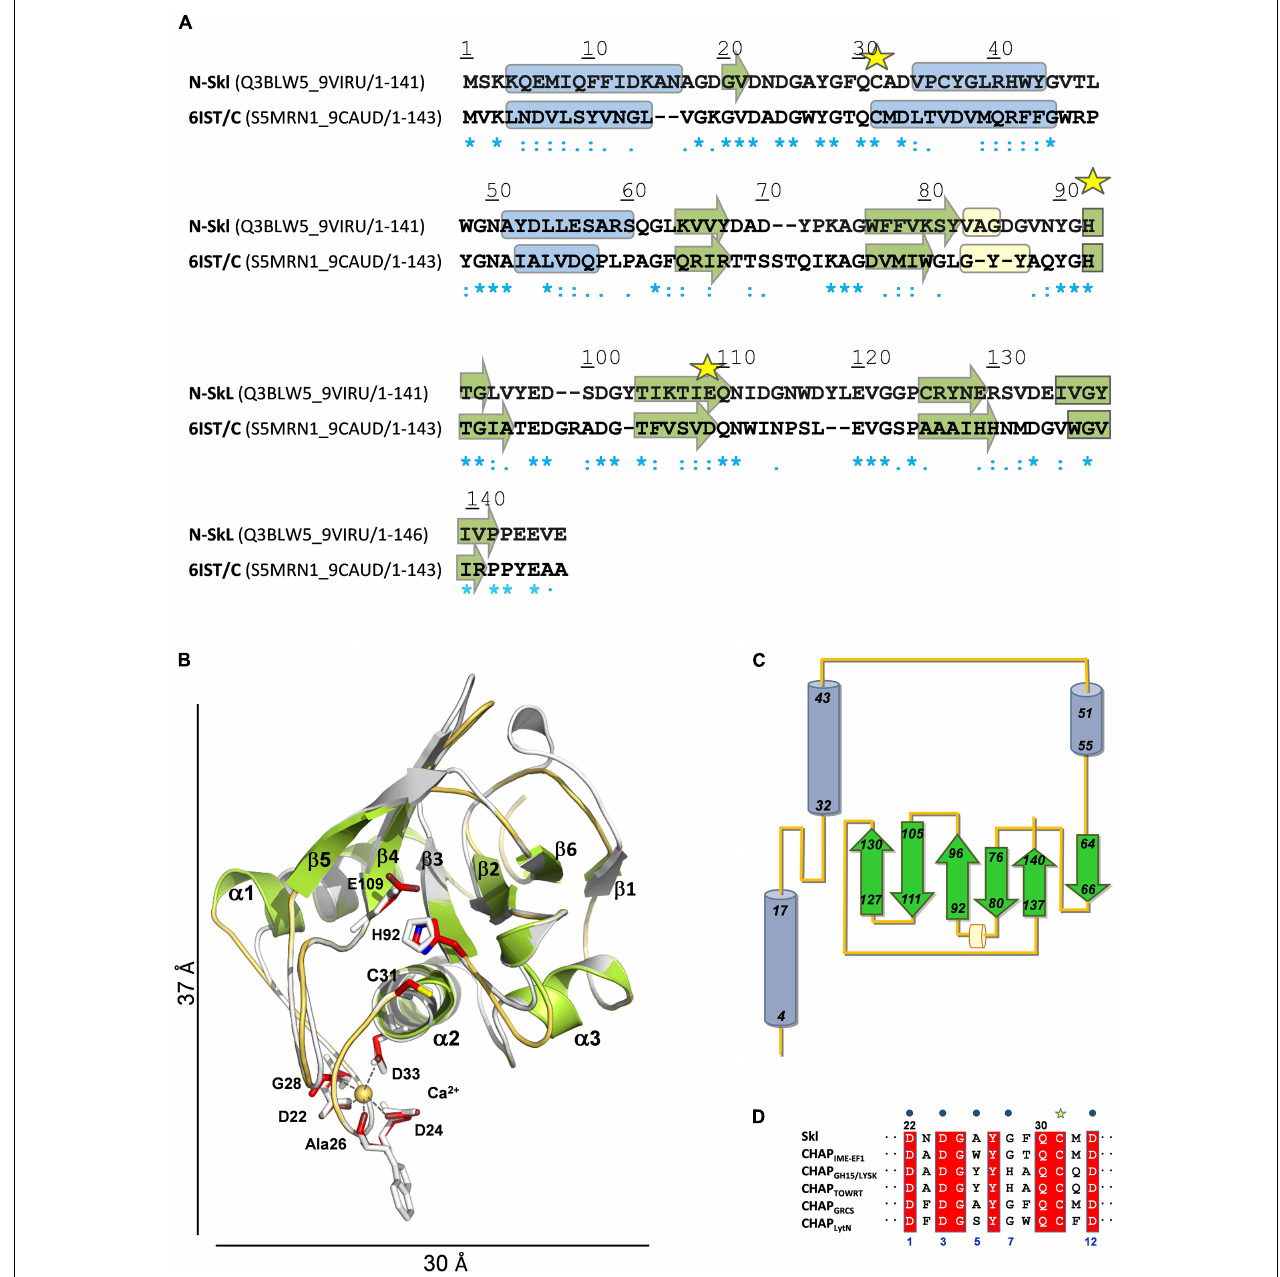
FIGURE 4 | Structural model of N-Skl. (A) Sequence alignment of the target and the template (PDB entry: 6IST) used by MODELLER. UniProtKB accession numbers and regions comprised in the alignment are shown in parenthesis. Symbols, cylinders, and arrows are as in Figure 3A . (B) Structural superimposition of the N-Skl model generated with MODELLER (cartoon representation: helices and arrows in green, loops in orange, and Ca 2 + cation yellow sphere) and the template (in gray). Catalytic and Ca 2 + -coordinating residues shown in stick representation are colored by element (C: red, N: blue; S: yellow) in N-Skl, or gray in the template. (C) Topology diagram of N -Skl structural model. (D) Sequence alignment of the 12-residue Ca 2 + -binding loop; blue dots indicate the Ca 2 + -coordinating residues (positions 1, 3, 5, 7, and 12).